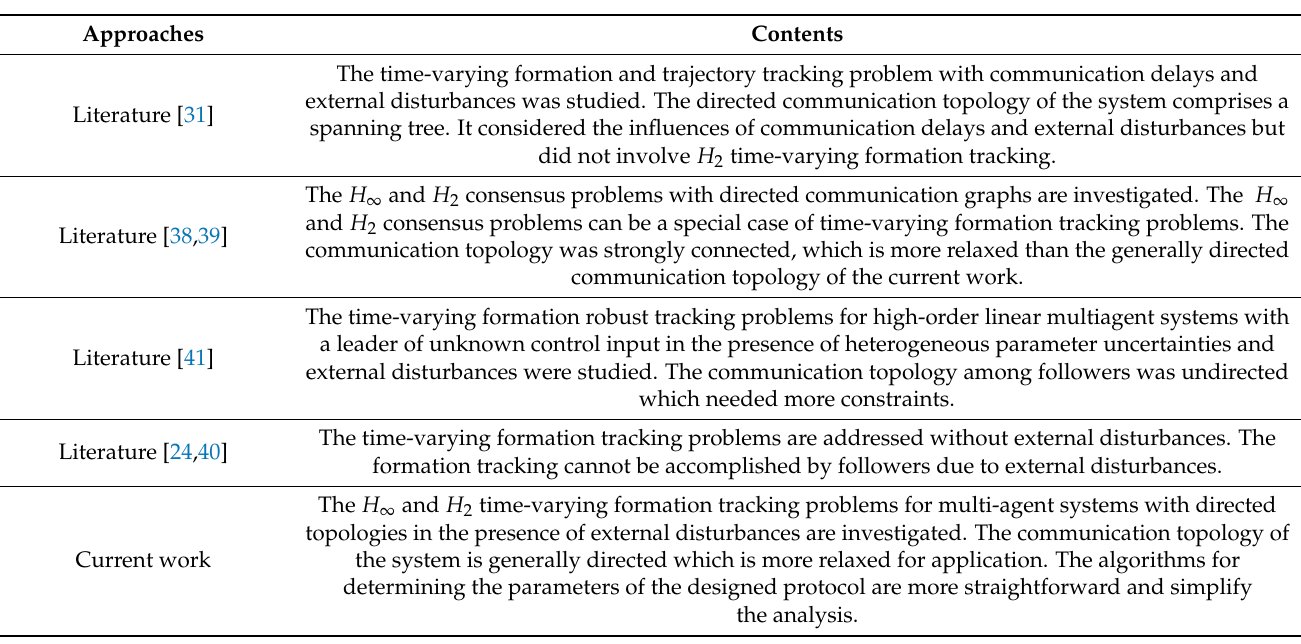
Table 1. Summary of typical previous research in comparison with the current